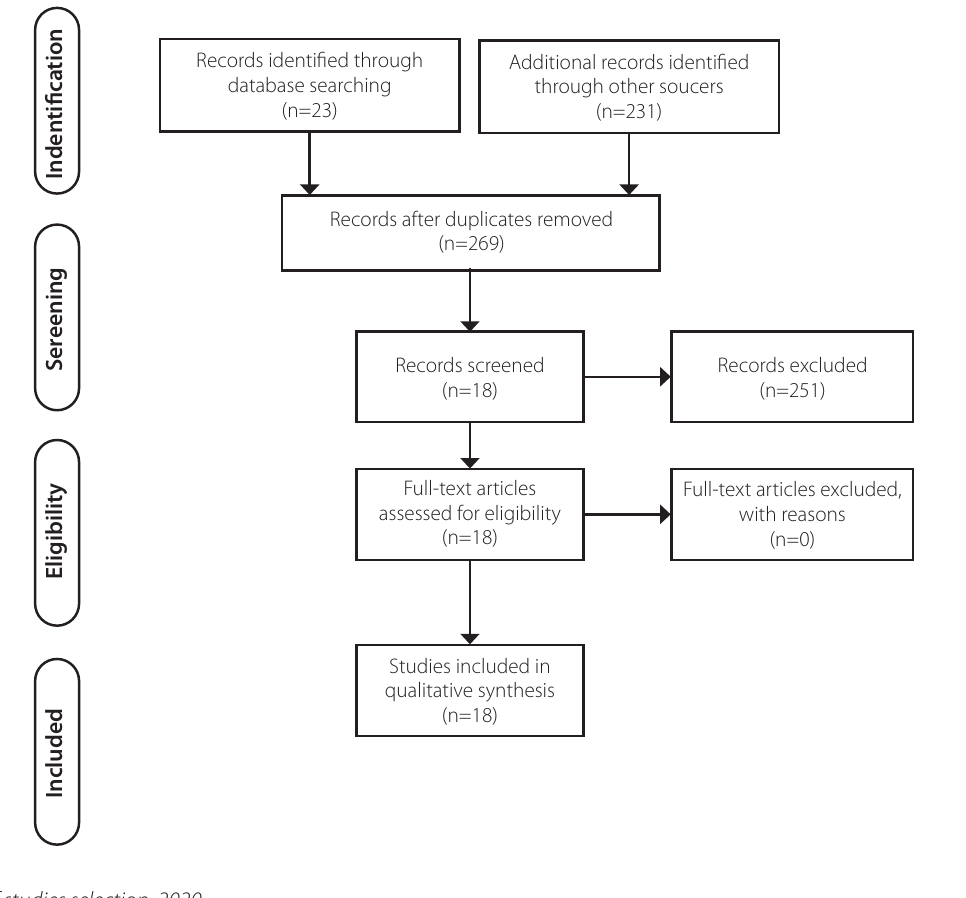
Fig. 1 - Flowchart of studies selection, 2020.